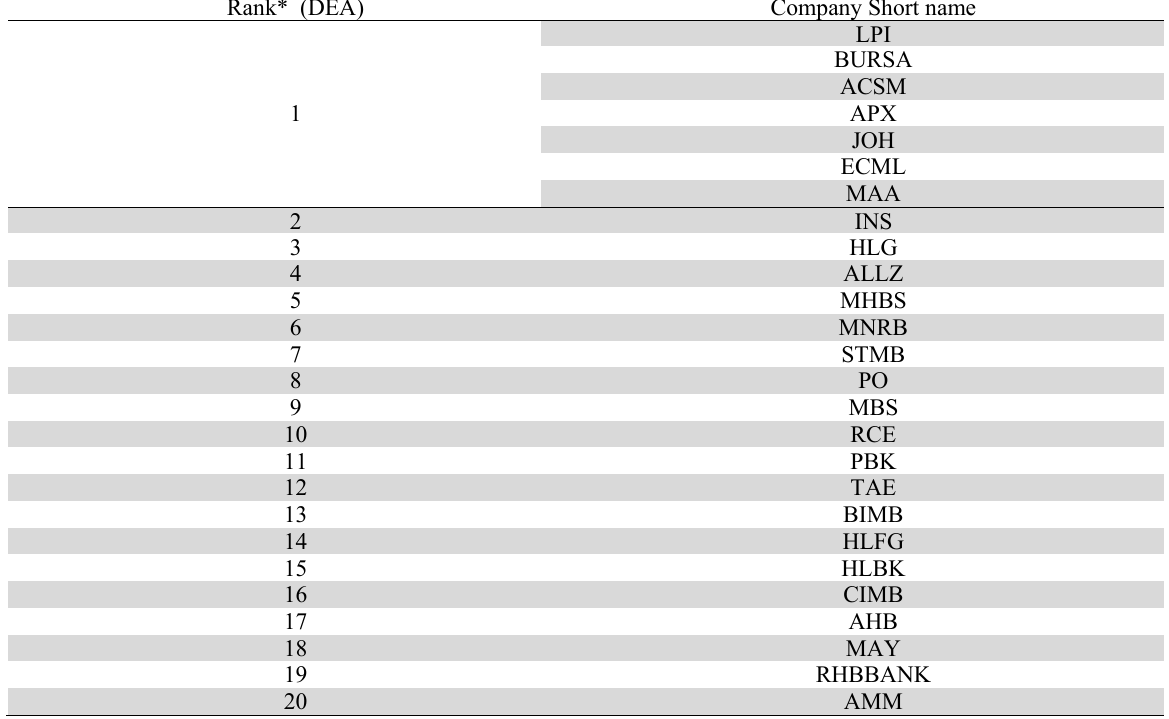
Ranking of the Financial Company Listed in Bursa